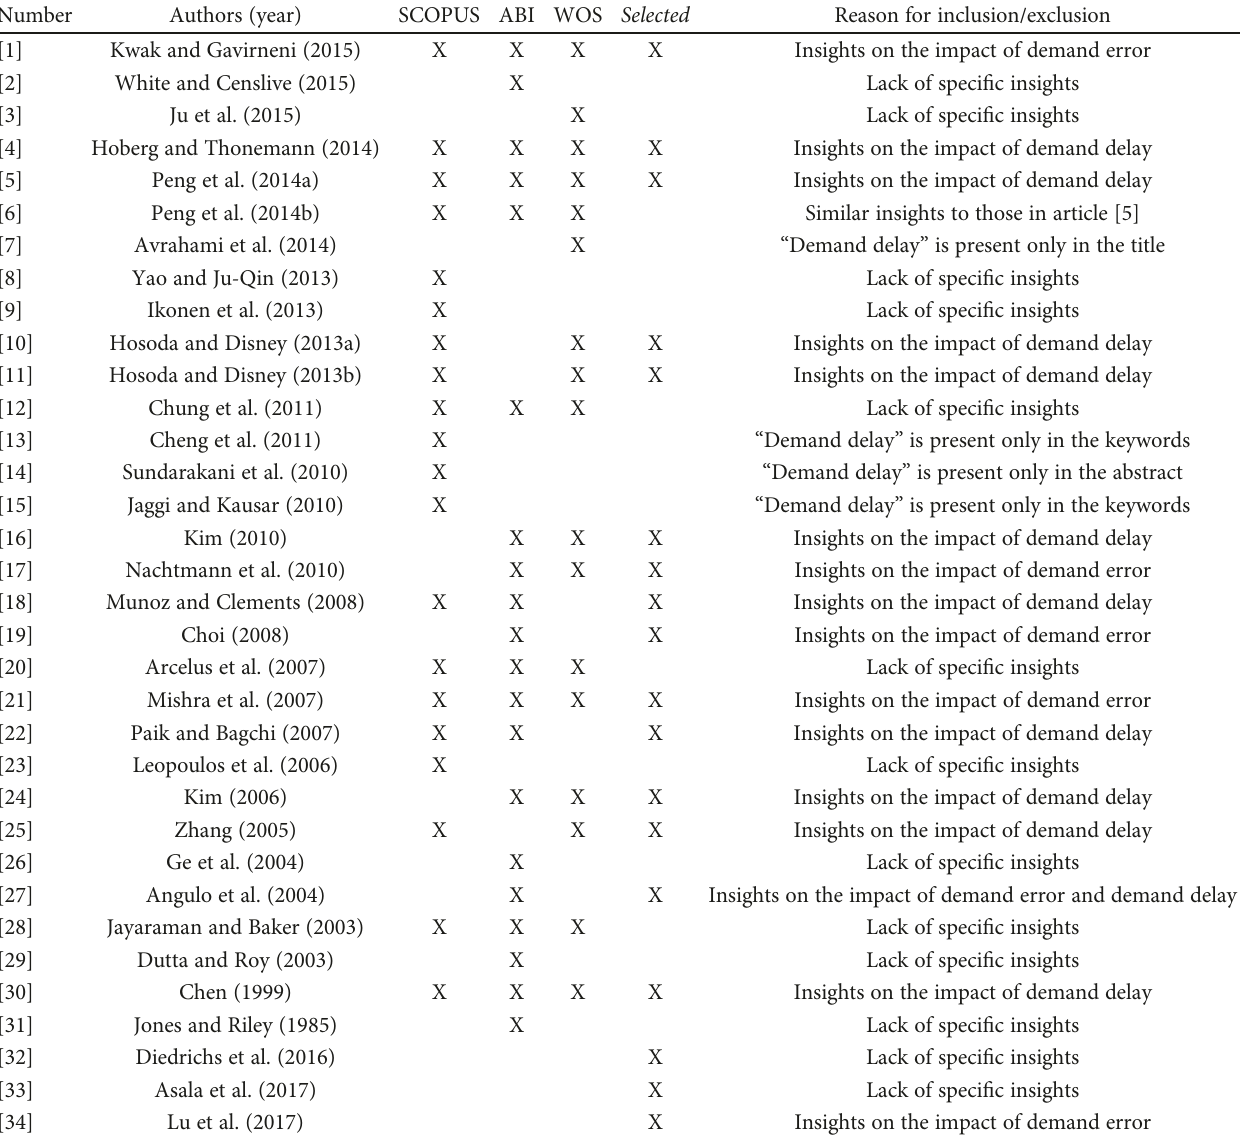
Table 1: Literature review: paper